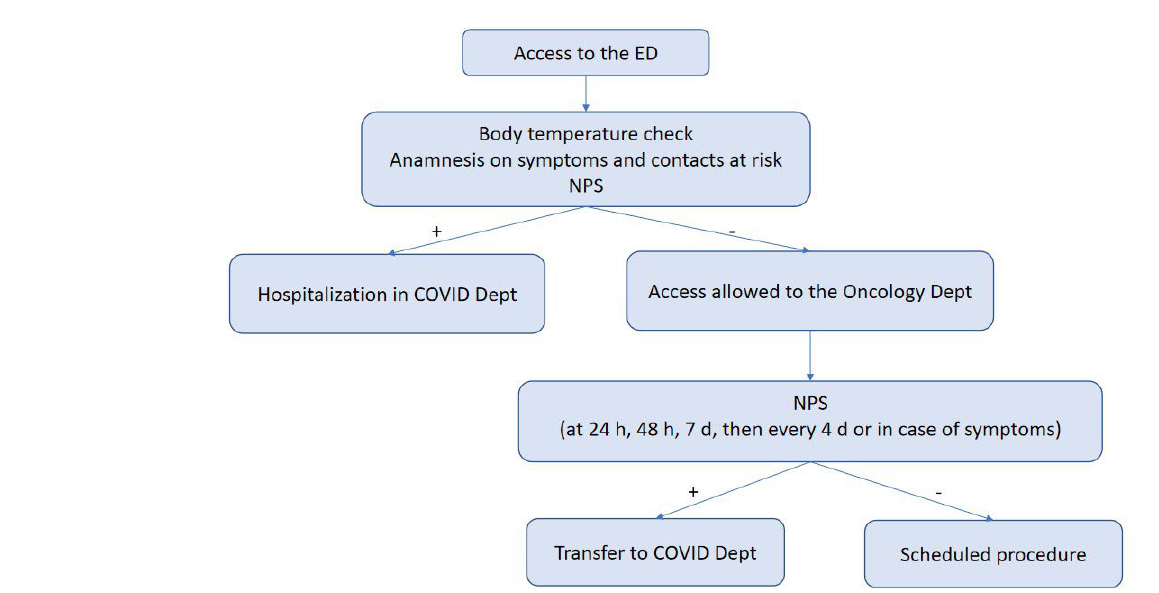
Figure 2. Flow chart of the COVID-19 screening protocol for inpatients. Dept: Department; d: